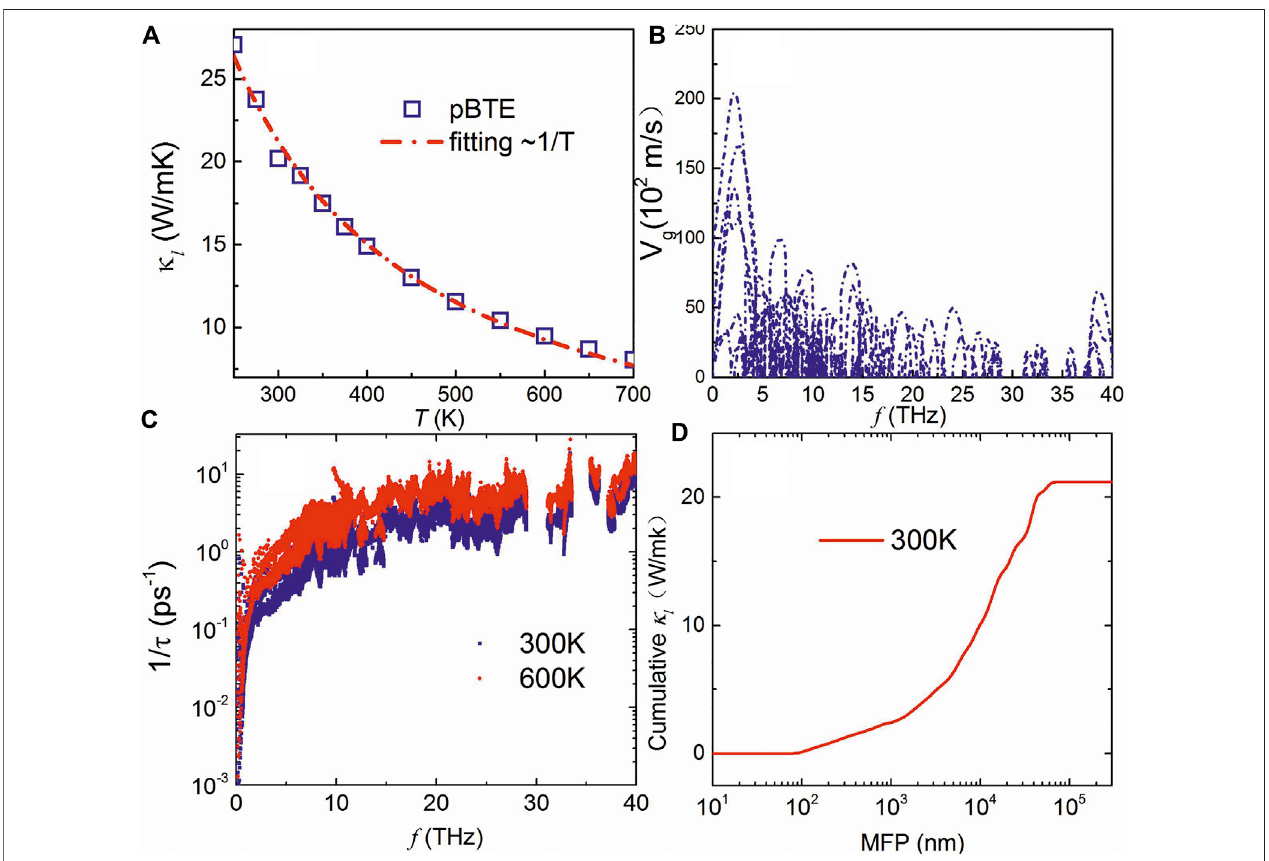
FIGURE 4 | (A) Calculated lattice thermal conductivity with respect to temperature, phonon group velocity (B) , and anharmonic scattering (C) of the β s 1 boron monolayer. (D) shows the cumulative lattice thermal conductivity with respect to the mean free path at 300 K.